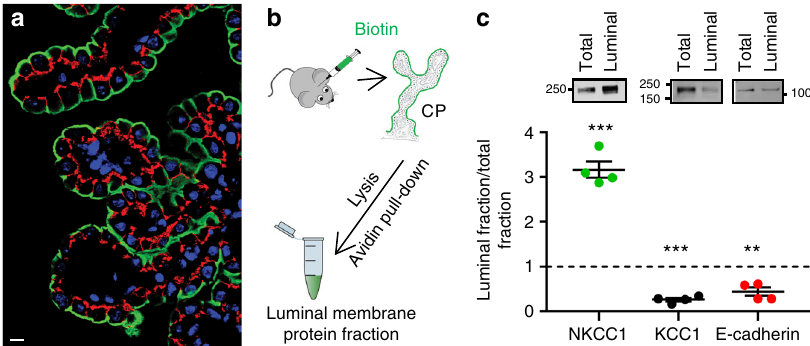
Fig. 3 NKCC1 is located at the luminal membrane facing the ventricles. a Immunostaining of mouse choroid plexus illustrated expression of NKCC1 in the membrane facing the lumen (green) with E-cadherin (red) as a basolateral marker and nuclei in blue. Scale bar = 10 µ m. Previously unpublished image generously provided by Dr. Jeppe Praetorius. b Schematic illustration of the luminal surface biotinylation of mouse choroid plexus in situ. c Representative western blots showing expression of NKCC1, KCC1, and E-cadherin in total tissue fraction ( F t ) and puri fi ed biotinylated (luminal) membrane protein fraction ( F l ). Below is depicted the quanti fi cation of protein abundance represented as luminal membrane/total protein fraction ( n = 4 mice). NKCC1 was expressed signi fi cantly higher in the puri fi ed luminal membrane fraction while KCC1 and E-cadherin were predominantly in the total fraction. Error bars represent standard error of the mean and statistical signi fi cance was determined with one-sample t test and comparison to equal distribution; F l / F t = 1 and the asterisks refer to a value signi fi cantly different from 1. ** P < 0.01, *** P ≤